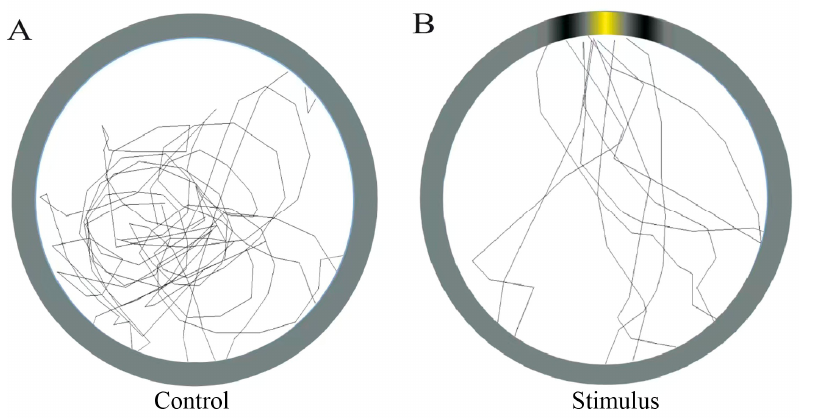
Figure 6. Movement behavior trajectories of Empoasca onukii in behavioral experiments. ( A ) Blank control, E. onukii search trajectories in the absence of stimulus and ( B ) E. onukii search trajectories in the presence of stimulus.